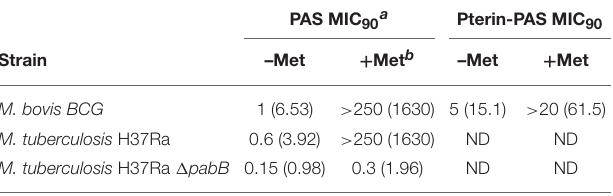
Frontiers in Cellular and Infection Microbiology |